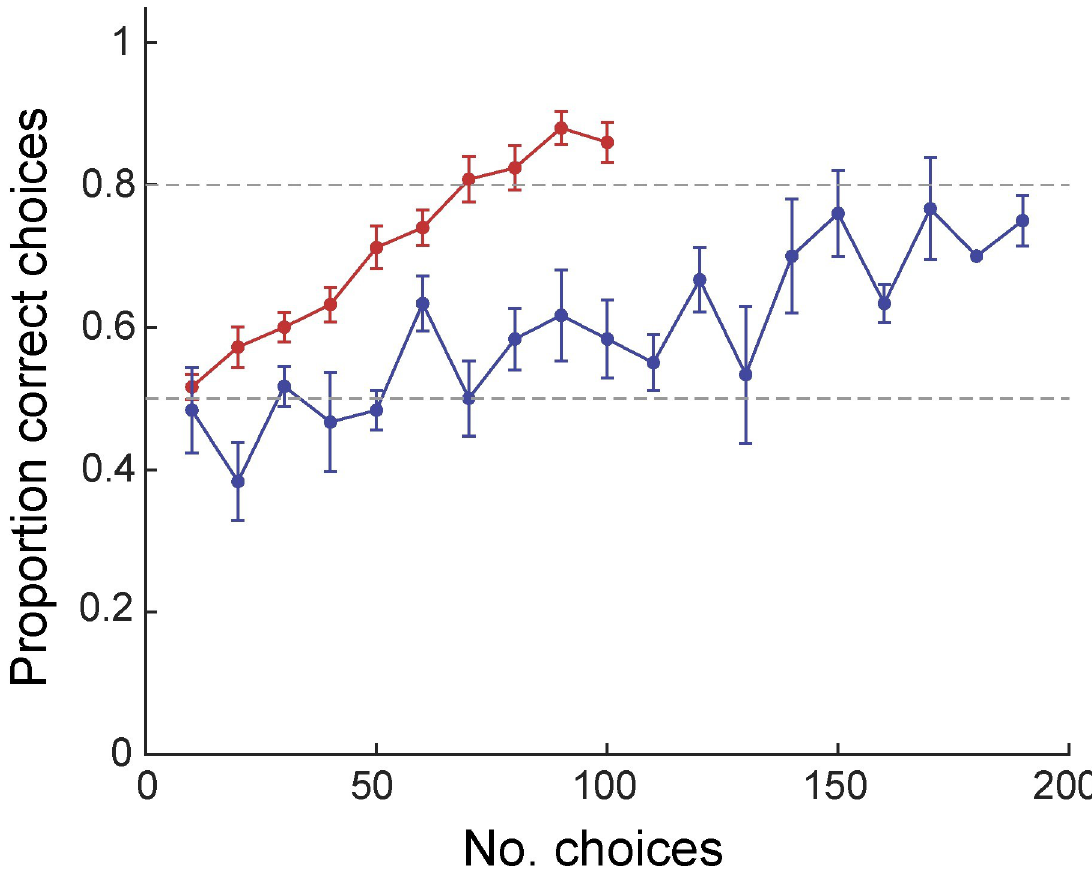
Fig 2. Learning curves for bees discriminating angles that differ by 7˚. Each marker shows the mean proportion of choices ( ± S.E.) for the trained angle, A , across a block of 10 consecutive choices. Red circles, experiment 1 (multiple-choice, N = 25); blue circles, experiment 2 (dual-choice, N = 6). Dashed grey horizontal lines indicate a chance level of performance (0.5) and the threshold criterion we used as a proxy for the end of the learning period (0.8, but note that bees had to reach this proportion of correct choices over 20 feeder visits).